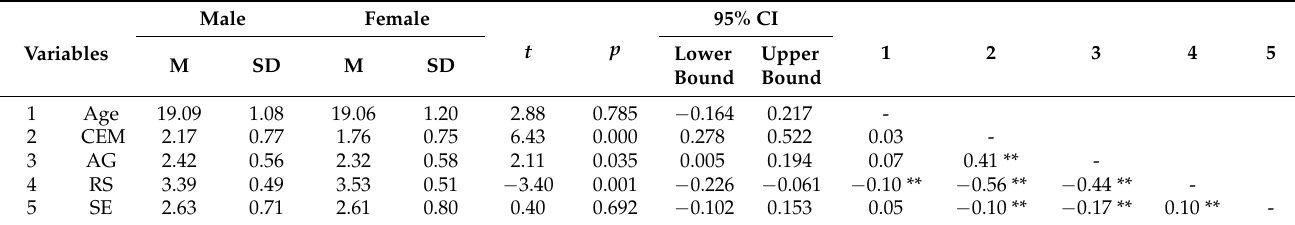
Table 2. Means, standard deviations, and correlations between all variables ( n = 809).